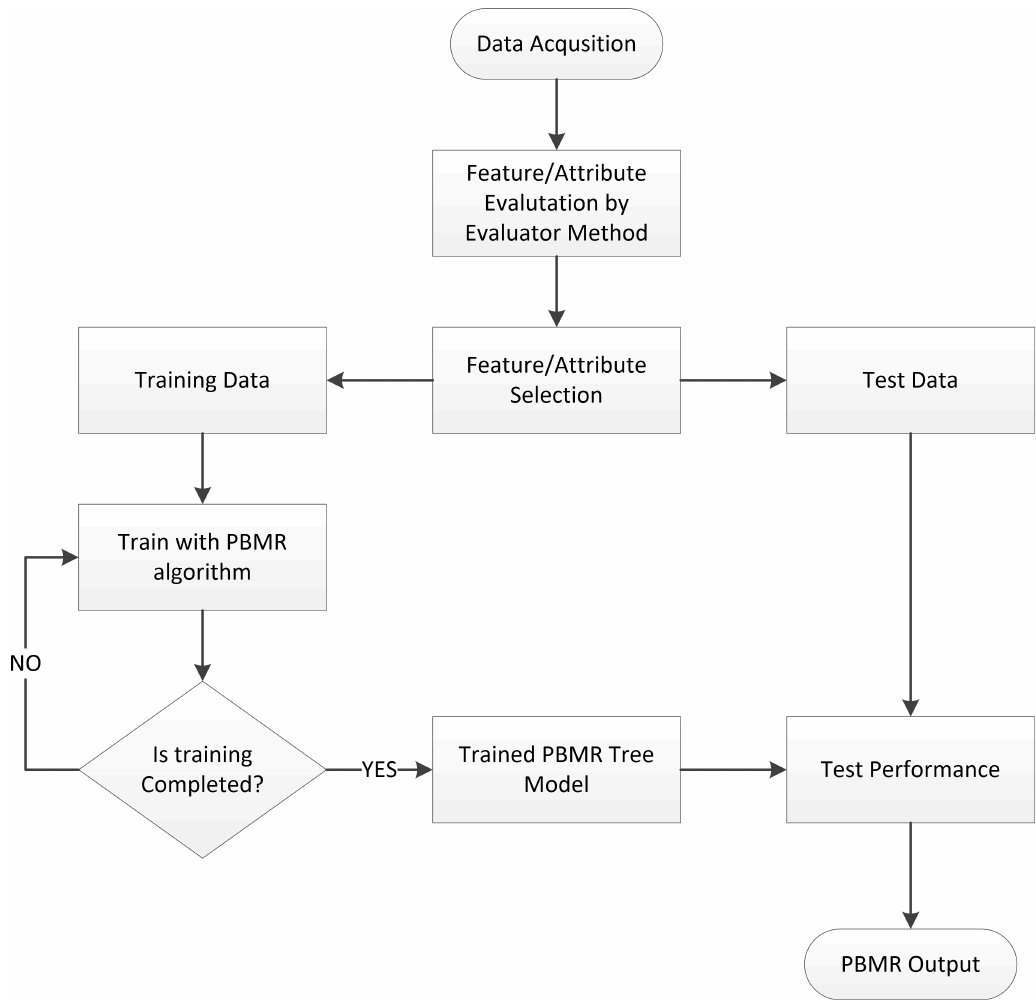
Fig 2. Proposed PBMR method